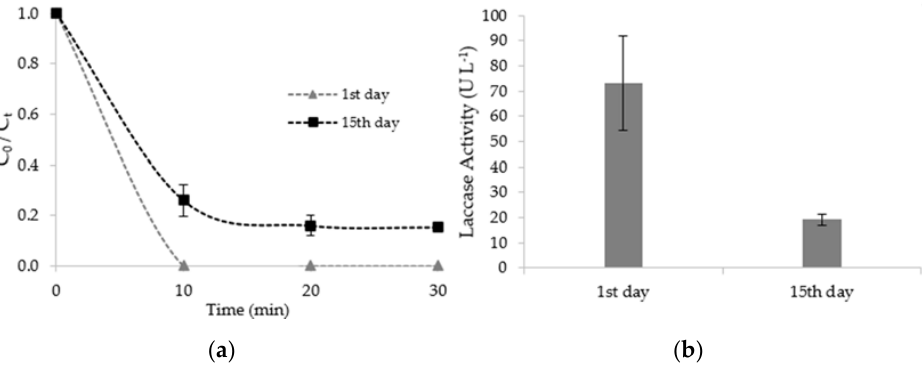
Figure 3. ( a ) Progression of fluoxetine concentration and ( b ) mean laccase activity of colonized mushroom substrate (CMS) at the first day and after fifteen days of storage.